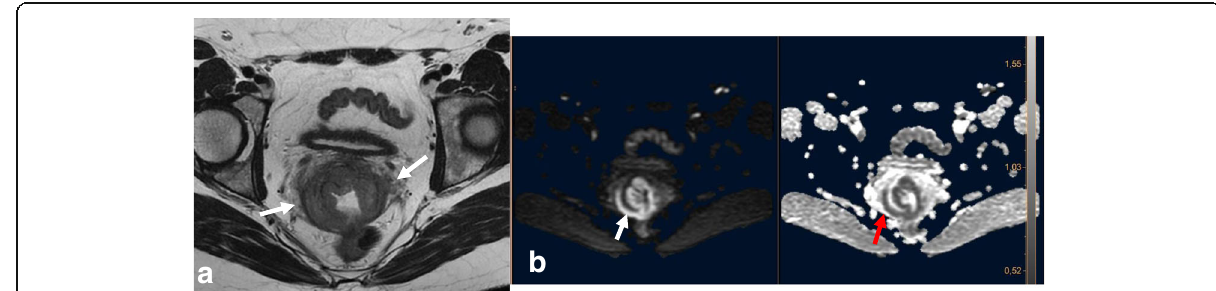
Fig. 15 FIGO IB2 cervical cancer, with post-biopsy cervical edema. Biopsy was performed 2 days before MRI. a Axial oblique T2WI shows cervical cancer with apparent parametrial invasion (arrows). b DWI ( b = 1000/ADC map) reveals a delineated tumor (arrows), without parametrial invasion